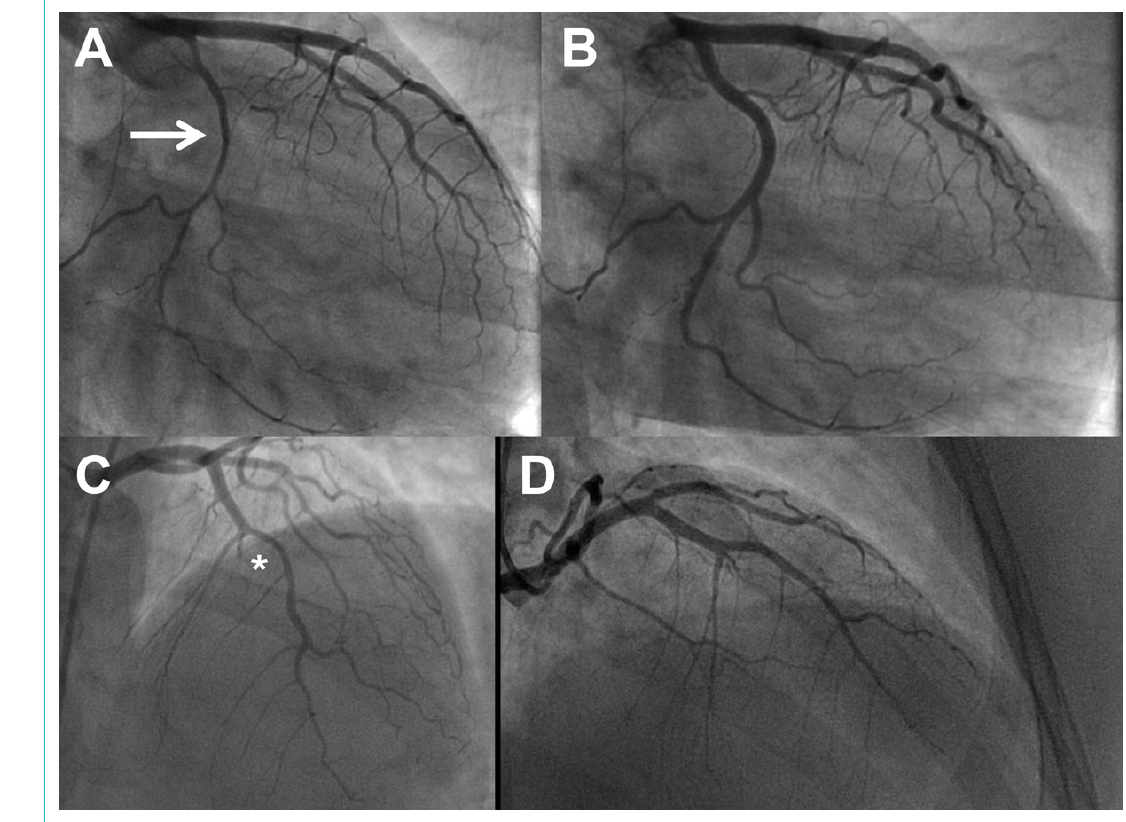
Figure 5: Serial angiogram of a 39-year-old woman with spontaneous coronary artery dissection (SCAD) on the entire left circumflex artery (LCX; panel A, right anterior oblique 35° view, arrow) and complete healing of the dissection at the repeat angiogram after 6 months (panel B, same view). Panel C: SCAD of the left anterior descending artery (LAD; asterisk) and the first diagonal branch 7.9 years later. Panel D: repeat angiogram 6 months later after conservative therapy showing healing of the dissections (cranial/right anterior oblique view) (see also table